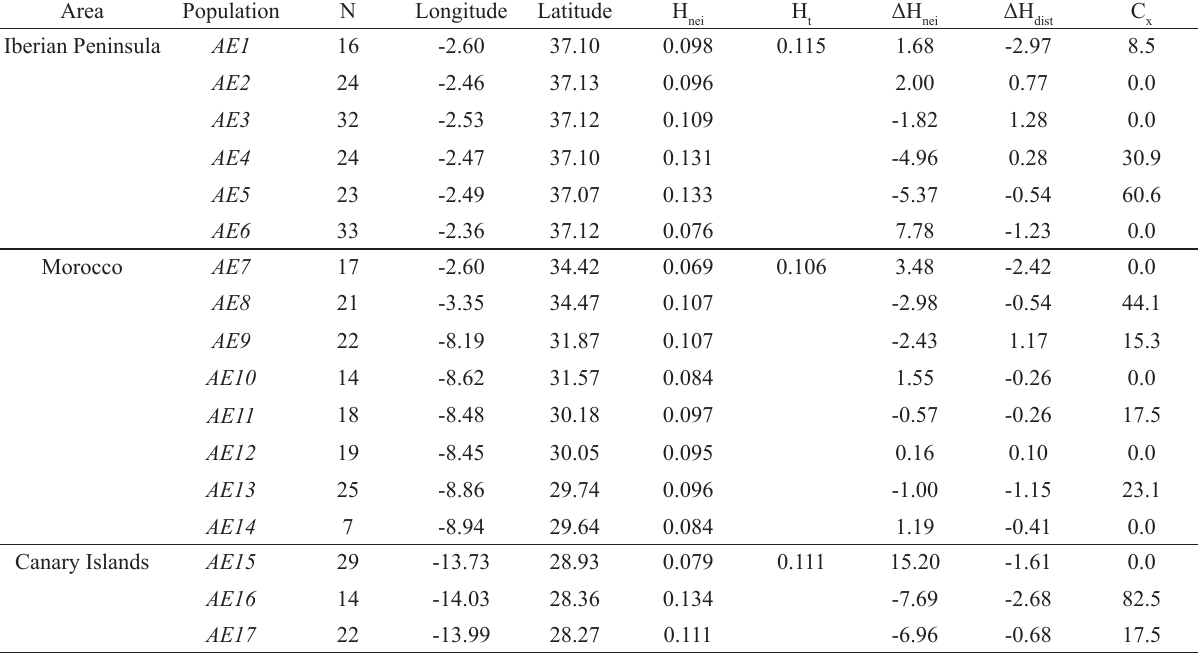
Table 1. Geographic and genetic diversity features of the populations of Astragalus edulis (N, Number of individuals used for the AFLP analyses; H , Nei’s gene diversity index; H , Nei’s average gene diversity values per Nei t geographical area) and Metapop2 v2.2.1 results (ΔH , proportional increment/decrement of the within- nei population gene diversity when the population data is removed in the analysis; ΔH , proportional increment/ dist decrement of Nei’s average genetic distance between populations when the population data is removed in the analysis; C , expected proportion of seeds from the populations within the geographic areas in order to obtain x the maximum diversity values in a synthetic